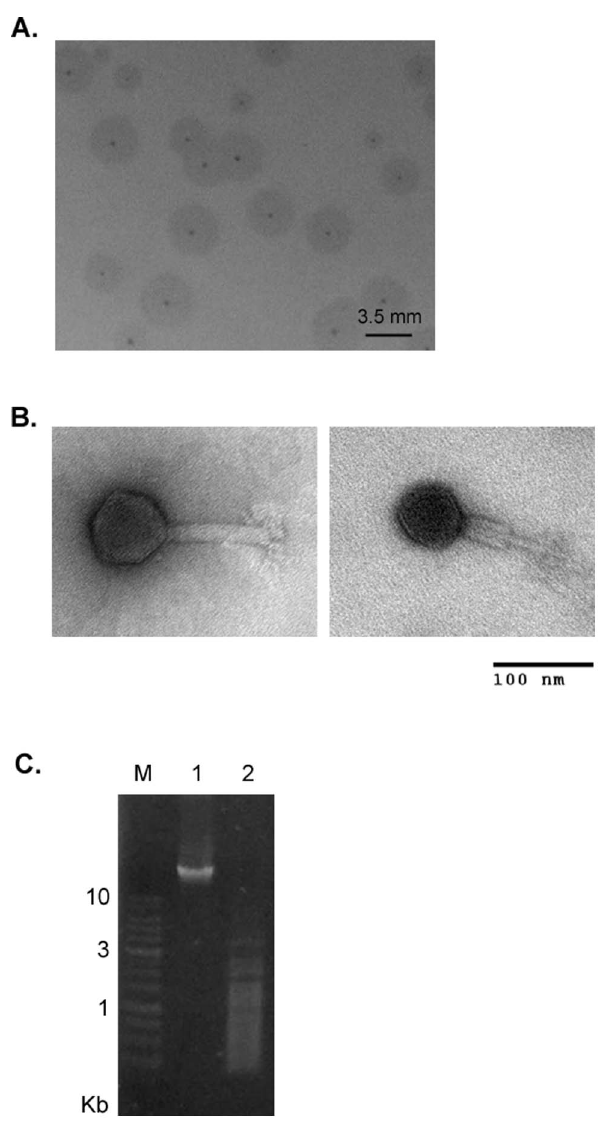
Figure 4. Characterization of phage 0507-KN2-1. ( A ) Plaque morphology of 0507-KN2-1 on K. pneumoniae Ca0507. Scale bar, 3.5 mm. ( B ) TEM images of 0507-KN2-1 taken at 150 000 6 magnification. Scale bars for both pictures, 100 nm. ( C ) Restriction digestion of 0507-KN2-1 genome. M: DNA marker; lane1: uncut genomic DNA, 2 m g; lane2: genomic DNA 2 m g incubated with HinPI1 at 37 u C for 5 h.